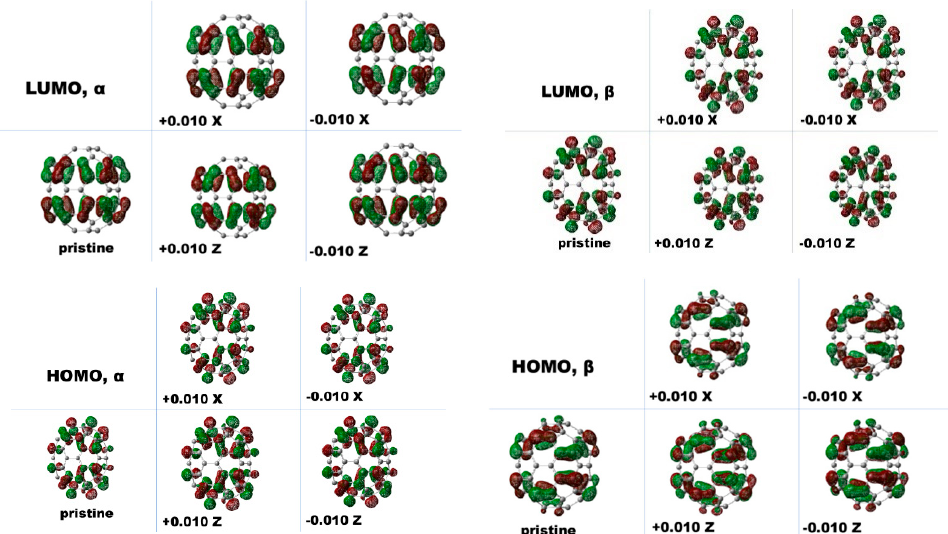
Figure 6. Frontier molecular orbitals diagram of the two orientation isomers of C 70 fullerene anion systems. The pristine anion is calculated at the B3LYP/6-31G (d, p) level including GD3. The others are for the B3LYP/6-31G (d, p) level including GD3 plus the point charges model. Here, X and Z represent the major and minor axis directions facing the point charges, respectively. The distance between the model point charges ( δ = 0.010) and the closest atoms of fullerene to the surface is 2.8 Å.